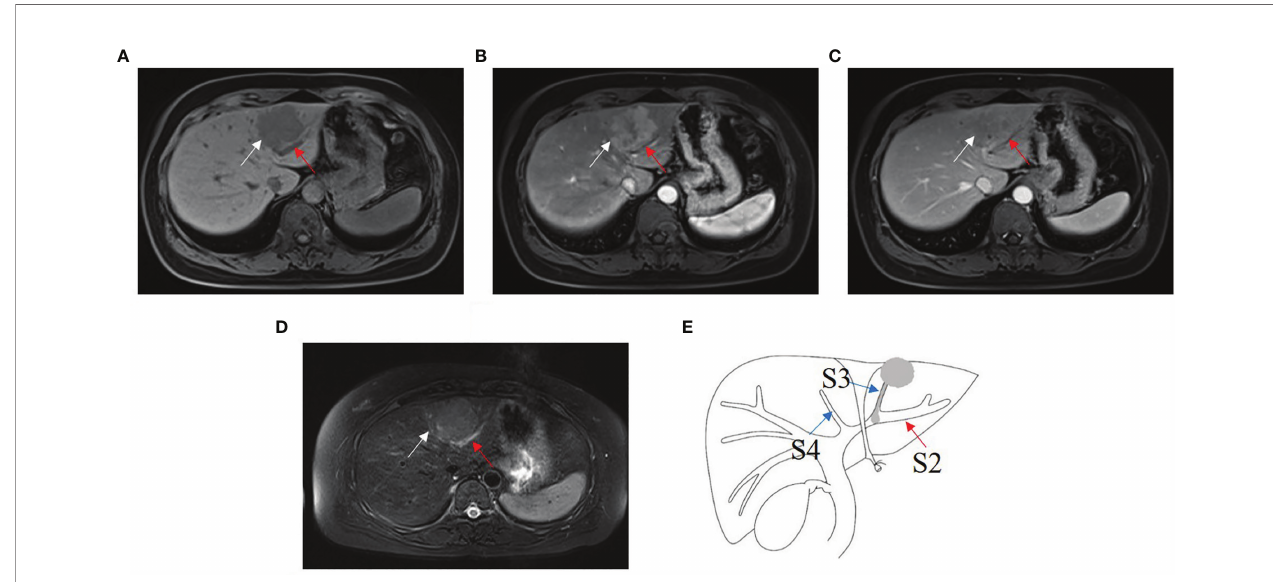
FIGURE 4 | HCC with B2 BDTT. (A) HCC lesion (white arrow) in S3 and bile duct dilation (red arrow) in S2 show slightly hypoattenuation on T1W. (B) HCC lesion shows early enhancement (white arrow head) at hepatic arterial phase. (C) Rapid washout of contrast material (white arrow) at portal venous phase, accompanied by the bile duct dilation (red arrow) in S2. (D) HCC lesion (white arrow head) in S3 and bile duct dilation (red arrow) in S2 show hyperintensity on fat-suppressed T2W. (E) HCC lesion, BDTT, and bile duct dilation (red